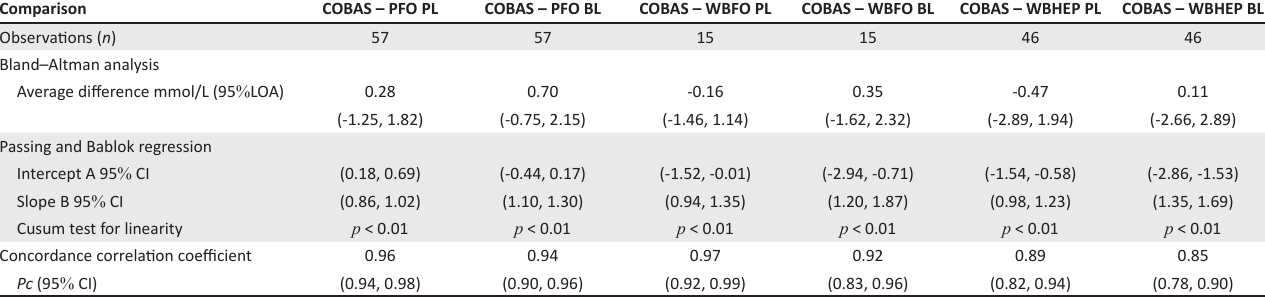
TABLE 1: Bland – Altman, Passing and Bablock and Concordance analysis of plasma lactate measured with a laboratory method compared with the Accutrend handheld meter. Lactate is measured on the Accutrend with different sample types using either the blood or plasma mode. Comparison